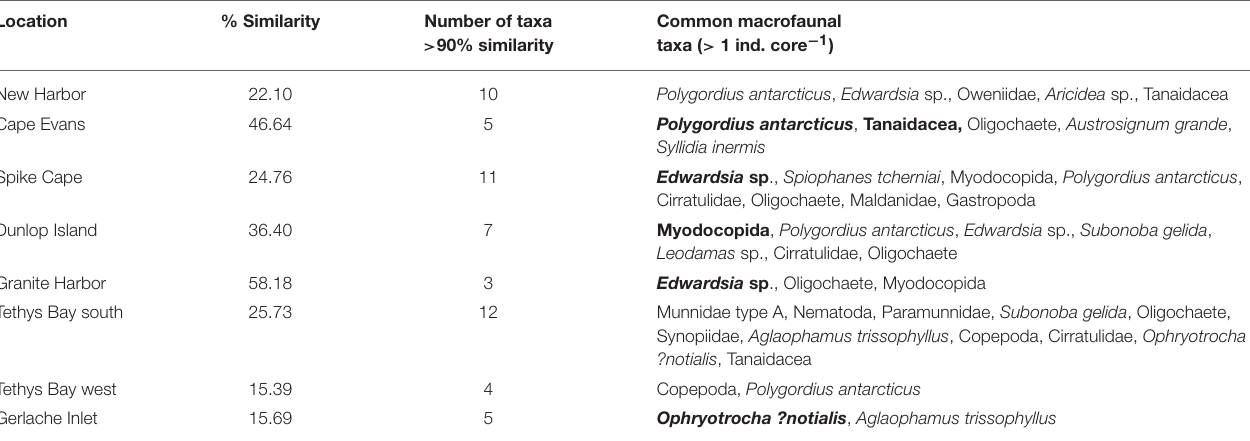
TABLE 5 | The percentage average similarity in macrofaunal community composition at each location, the number of taxa contributing to 90% of the similarity, and the taxa found in average abundances of > 1 ind. core − 1 . Location %